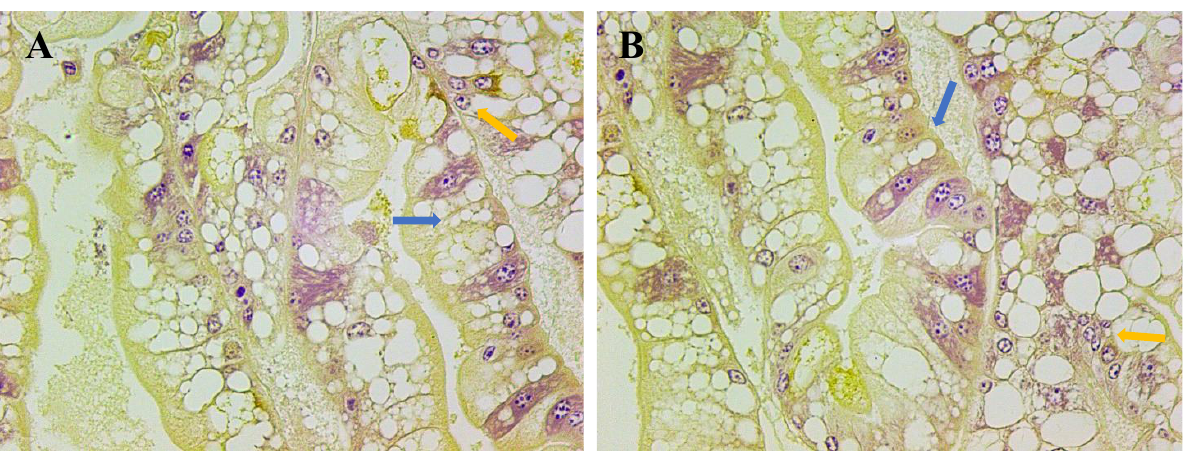
Figure 4. Hepatocyte apoptosis of Macrobrachium rosenbergii fed with different dietary fat and VE levels. ( A ) prawns fed diet including 9% fat and 200 mg/kg VE; ( B ) prawns fed diet including 9% fat and 600 mg/kg VE; ( C ) prawns fed diet including 13% fat and 200 mg/kg VE; ( D ) prawns fed diet including 13% fat and 600 mg/kg VE; ( E ) ratio of hepatopancreatic apoptosis cells ( n = 3). Blue arrow: normal cells; yellow arrow: apoptotic cells. **: p < 0.01, *: p < 0.05.